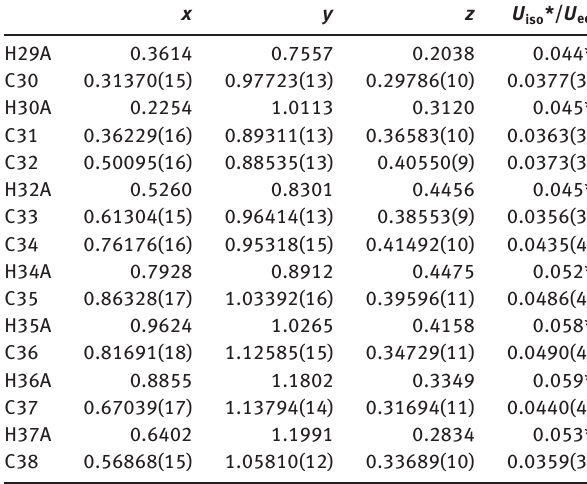
helicobacter pylori infection [7], radioprotective activity [8] and so on. There are two crystallographically independent molecules in the asymmetric unit of the title structure ( cf . the figure). They show pseudo-translational symmetry as dis- cussed before [9]. Bond lengths and angels are all in the ex- pected ranges. Thedieder angles of O3-C11-C1-C10 is 75°, while the O6-C30-C20-C29 is 110°. The bond angle of C11–C12–C13 is 124.39(13)°, but the C30-C31-C32 is